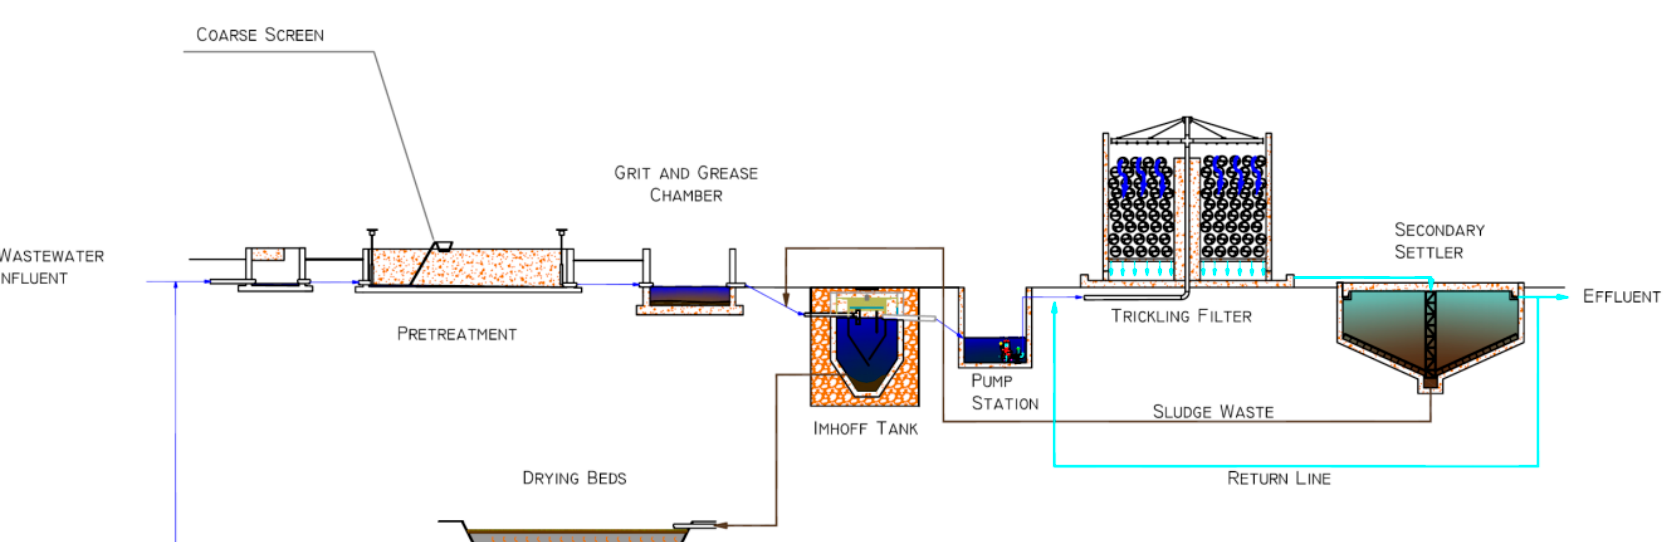
Figure 10. Flow diagram of the treatment process, outlining the main path: Incoming sewage enters a receiving chamber (buffer for peak loads) and is directed through a coarse screen into a static grit and grease chamber to remove sand (and garbage thrown into open sewers). It then enters the Imhoff tank. The stabilized sludge from the tank is occasionally pumped into drying beds (reduction of sludge volume) and the effluents are pumped into the trickling filter. The treated wastewater is then collected in a secondary settler and chlorinated.